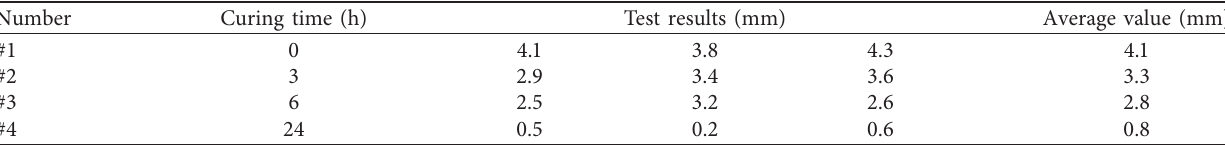
Figure 8: Schematic diagram of embedding depth of specimen aggregate. Table 5: Test results of embedding depth under different curing times.